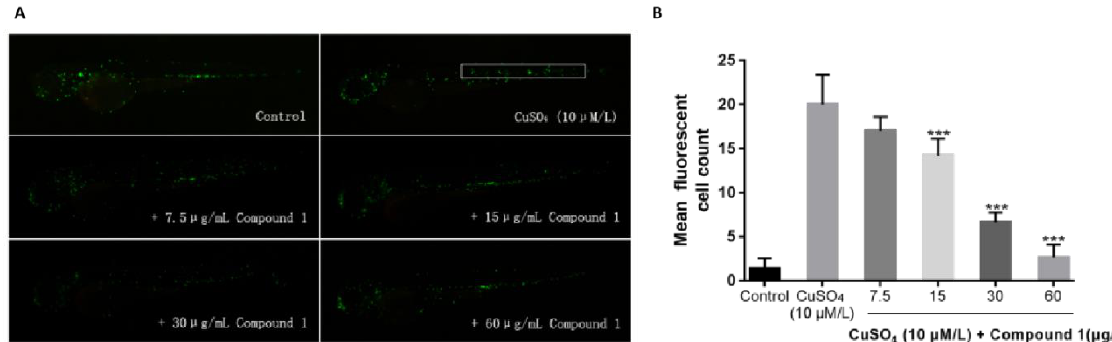
Figure 5 . Effect of compound 1 on immune cell migration in CuSO 4 -stimulated inflammation in zebrafish. ( A ) Representative images of zebrafish treated with compound 1 and CuSO 4 ( B ) Macrophages in the region of the neuromast were quantitatively analyzed. Each value represents the mean ± SEM from three independent experiments (*** p < 0.001 versus with the CuSO 4 group).